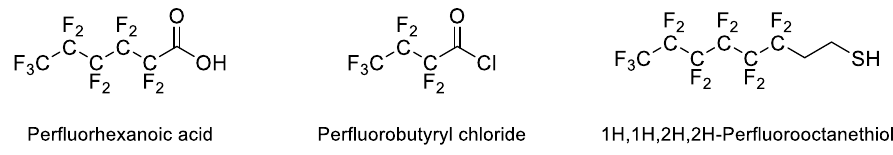
Figure 1. Fluorinated reagents employed in the fluorine-containing dendrons synthesis.